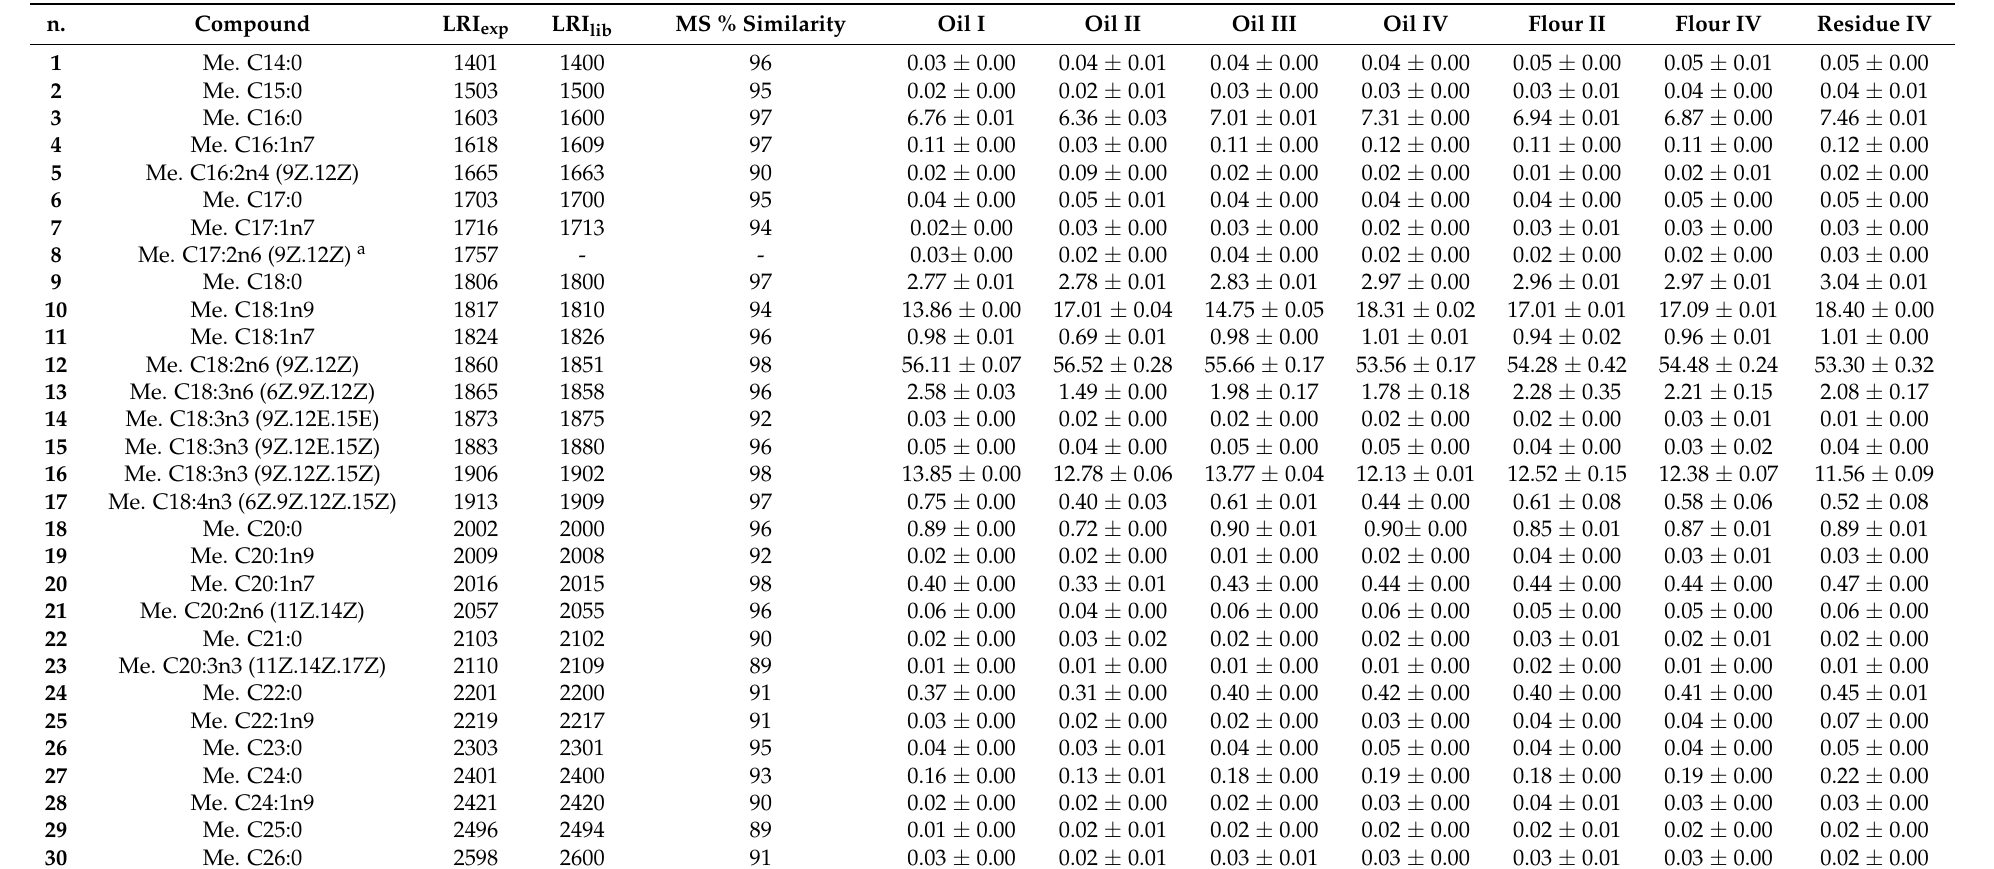
Table 1. Identified FAMEs in the lipid fraction of hempseed-derived products, along with their MS similarity (%), comparison between experimental (exp) and tabulated (tab) LRI values and the relative content